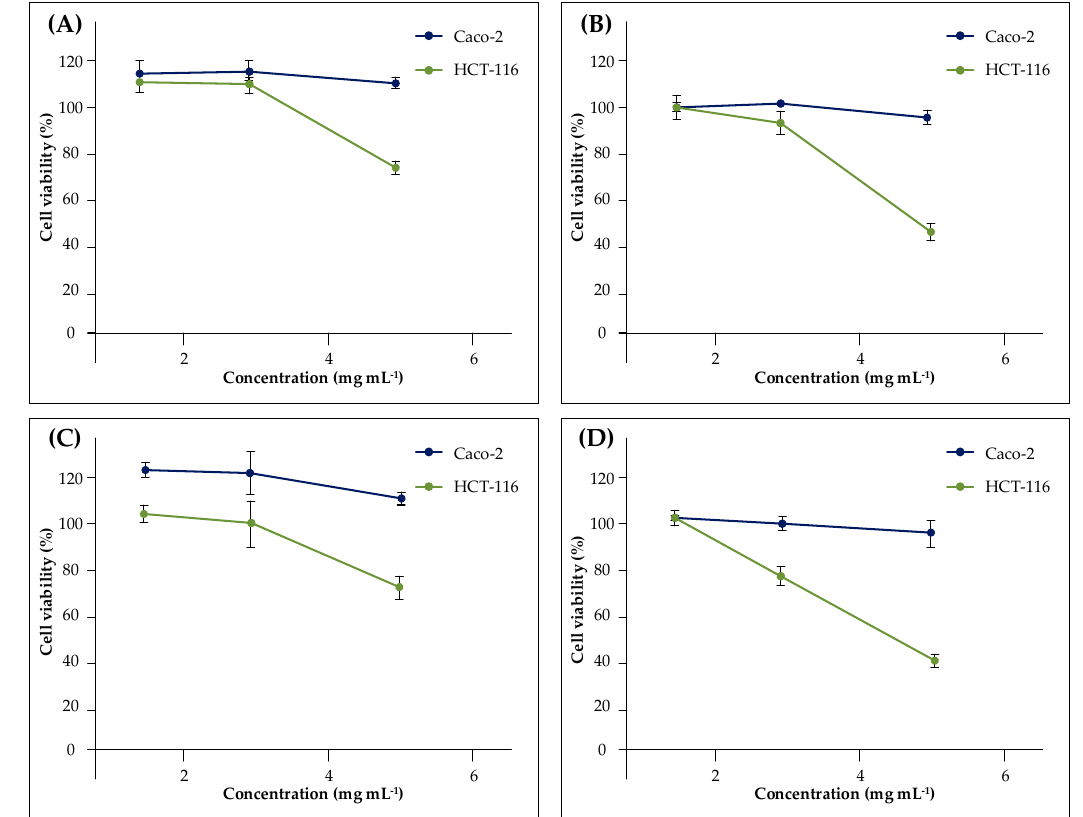
Figure 2. Cell viability assay on Caco ‐ 2 (non ‐ invasive) blue line and HCT ‐ 116 (invasive) green line after treatment with aqueous extracts obtained by hot water extraction (HWE; A , B ) and rapid solid ‐ liquid dynamic extraction (RSLDE; C , D ) at different concentrations. The response was observed after ( A , C ) 24 and ( B , D ) 48 h exposure.